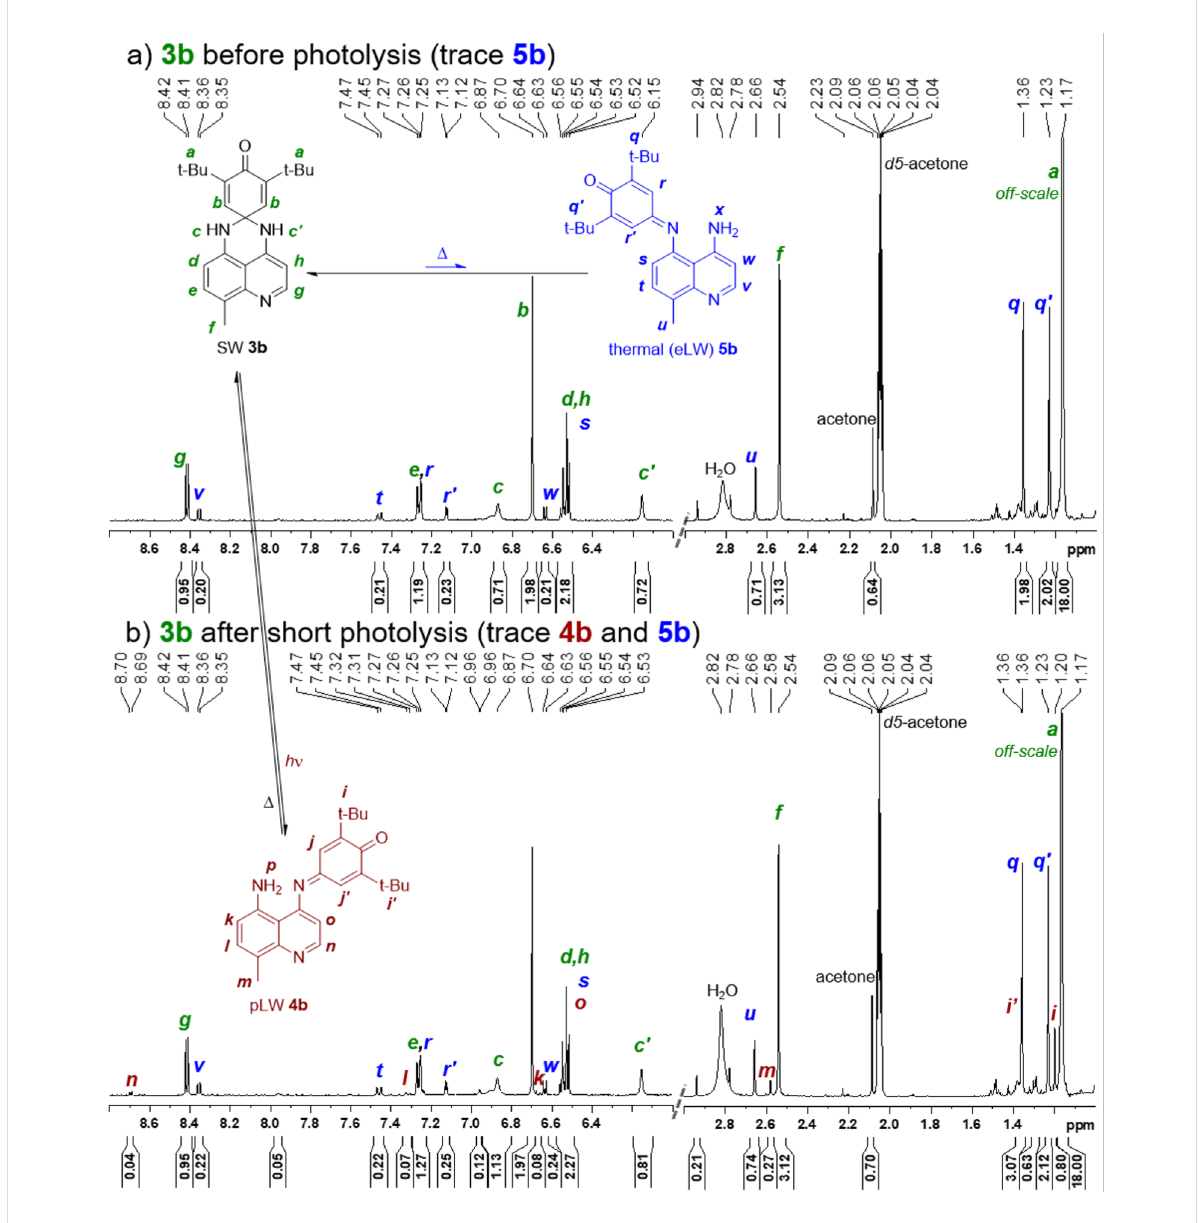
Figure 5: 1 H NMR distinction between SW 3a , thermal/eLW 5a , and pLW 4a , in acetone- d 6 , as observed a) before and b) after